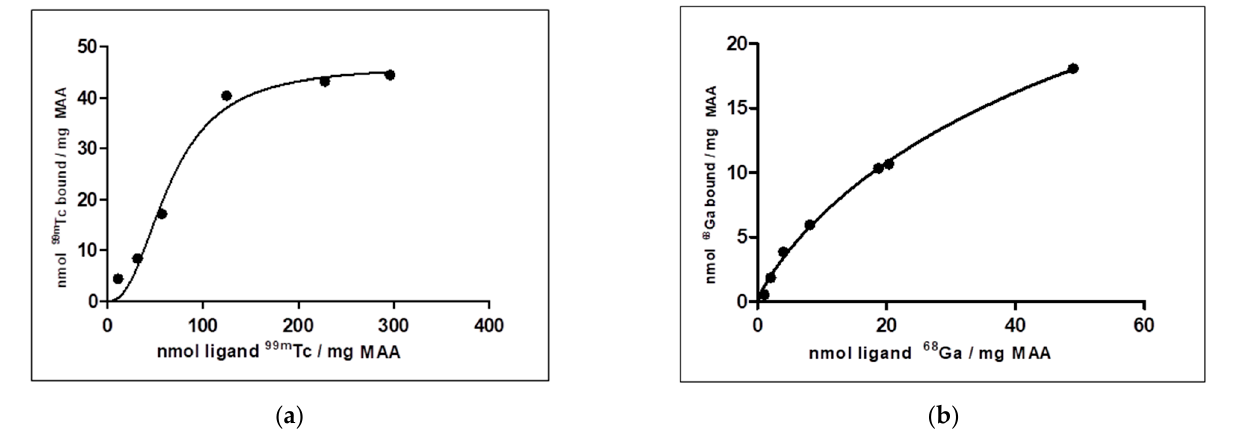
Figure 5. Saturation binding experiments (one site-specific binding determined by the Hill slope equation) for binding affinity between MAA and 99m Tc ( a ) and 68 Ga ( b ).